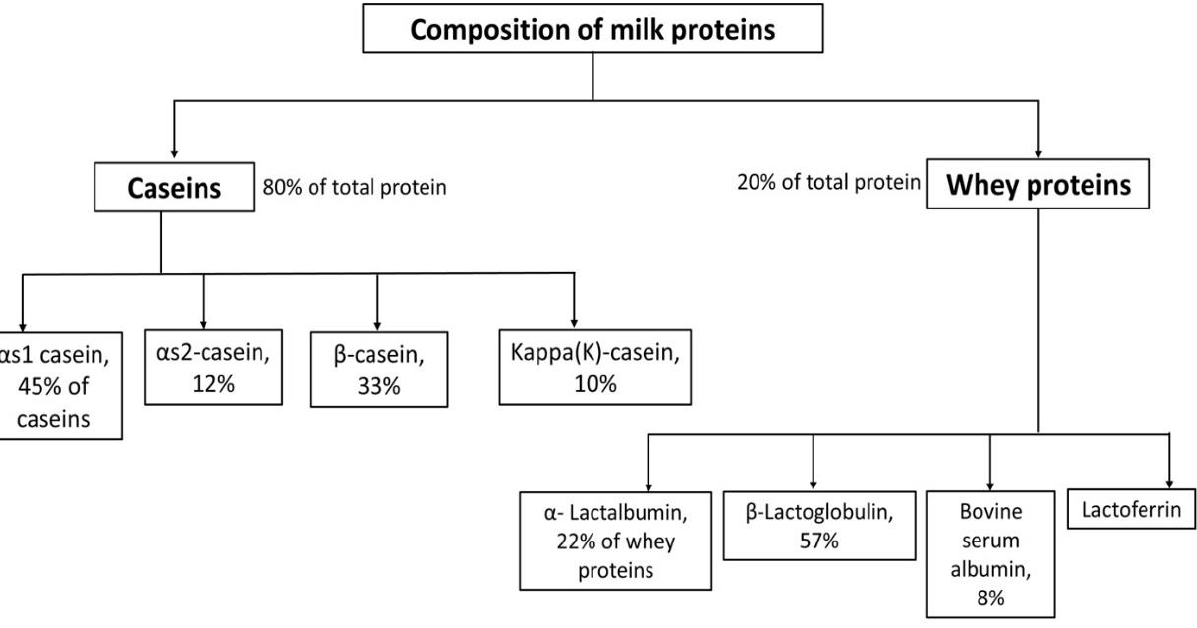
Figure 5. Flow chart of the composition of bovine milk (Data collected from Abd El-Salam et al. [92] and Onwulata et al. [93]).